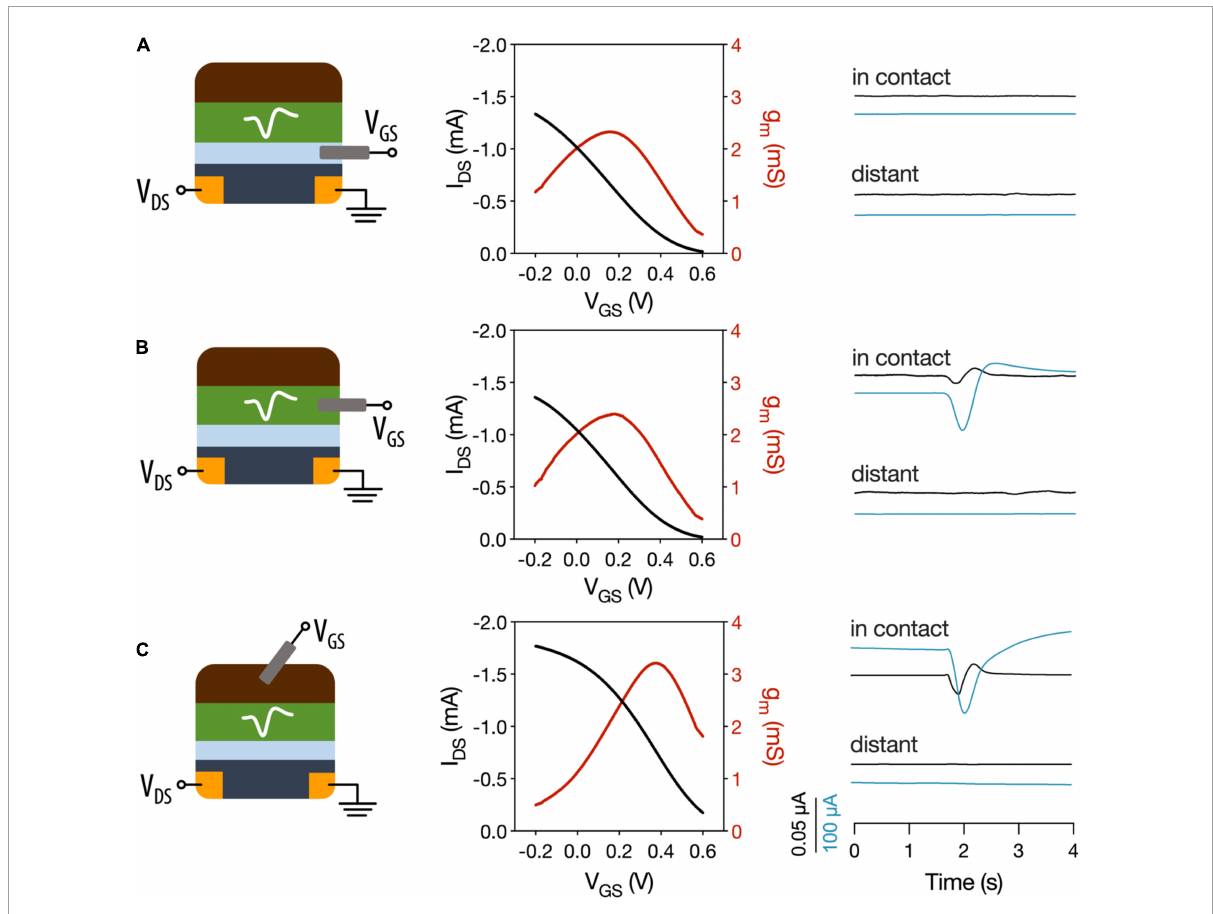
FIGURE2 Different OECT configurations for plant electrophysiology. OECT transfer curves and transconductance and VFT action potentials recorded with (A) OECT co-planar PEDOT:PSS gate electrode. (B) Ag/AgCl electrode in a non-electrically active plant tissue as the gate electrode. (C) Ag/AgCl electrode in soil used as gate electrode. In contact refers to a recording of the trap where the OECT channel is attached. Distant corresponds to recordings in which a different trap was stimulated. Black trace: gate current. Blue trace: drain